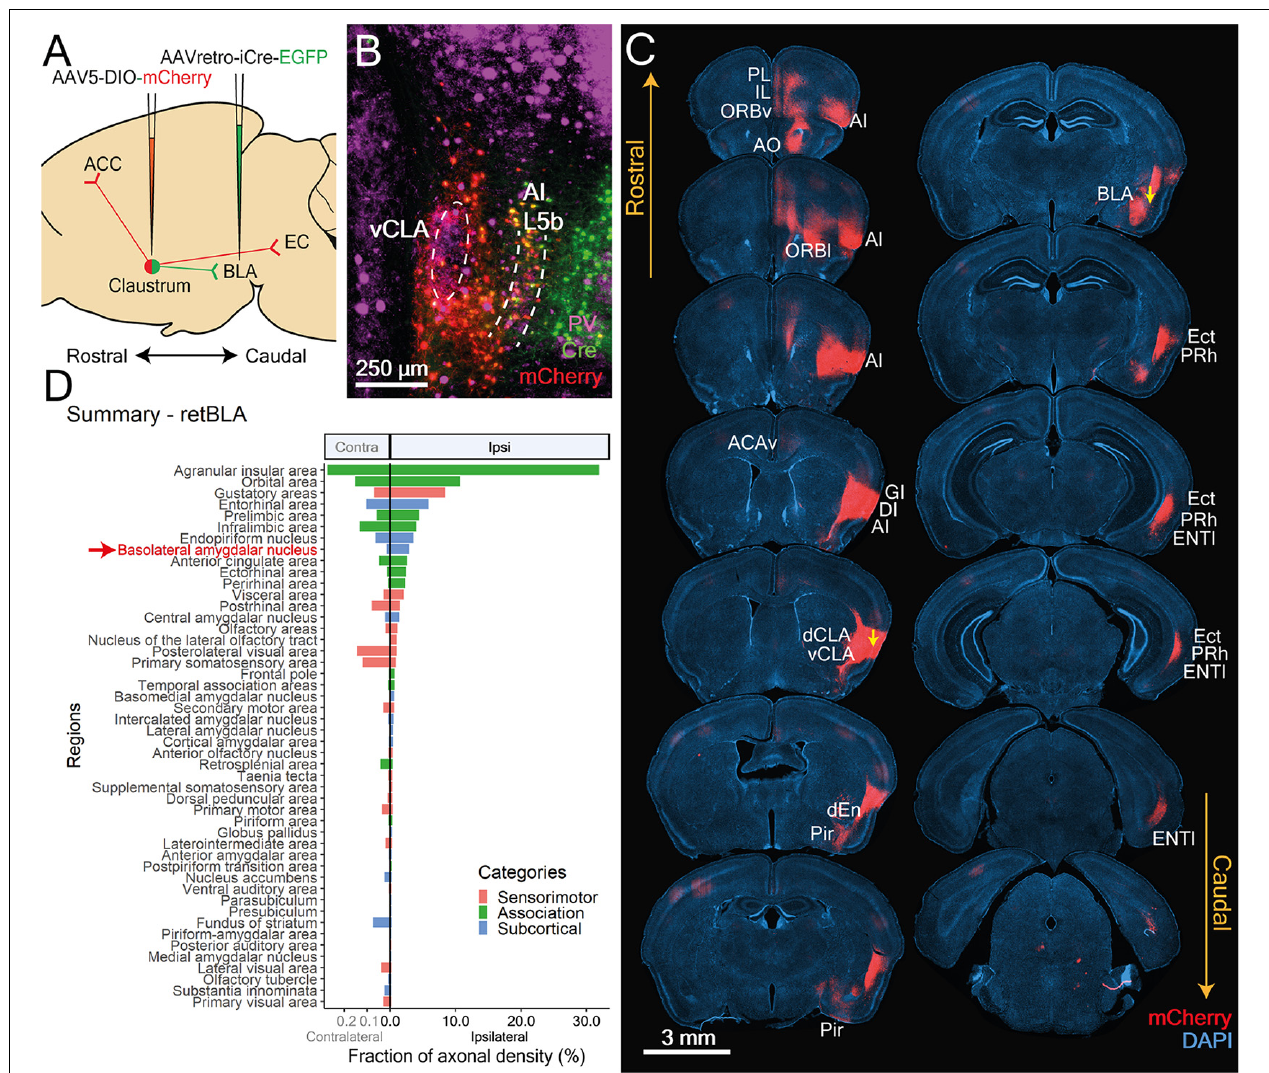
FIGURE 7 | CLA neurons projecting to the BLA reside in a shell-like region surrounding the vCLA core and co-project to limbic-related cortices. (A) Illustration of double virus injection strategy used to label CLA neurons projecting to the BLA and its axon arborizations. (B) CLA-specific expression of Cre and mCherry based on experiment shown in (A) . vCLA core boundaries (white dotted ellipse) and layer 5b of the anterior insula (white dotted lines) are demarcated based on parvalbumin (PV) antibody staining. (C) Mapping of axon collateral from BLA-projecting CLA neurons. Raw images of mCherry expression against DAPI stained coronal sections. Yellow arrows denote viral injection sites. CLA neurons projecting to BLA also project to several other limbic-related cortices. Regions receiving arborizations are labeled. PL, Prelimbic; IL, Infralimbic; AO, anterior olfactory nucleus; AI, Agranular insula; ORBv, ORBl, Orbital cortex ventral, lateral; ACCv, Anterior cingulate cortex ventral; GI, DI, Granular, Dysgranular Insula; dCLA, vCLA, dorsal, ventral claustrum; dEn, dorsal endopiriform nucleus; Pir, Piriform cortex; BLA, Basolateral amygdala; Ect, Ectorhinal cortex; Prh, Perirhinal cortex; LEC, Lateral entorhinal cortex; Sub, Subiculum. (D) Mean fraction of axonal density for all innervated regions sorted by strength. Red arrow and text identify retrograde Cre origin: BLA. Several regions had heavier innervation compared to the BLA. These include the agranular insula, orbital, gustatory, entorhinal, prelimbic, and infralimbic cortices as well as the endopiriform nucleus. Colors represent region categories: Association—green, Sensorimotor—pink, and Subcortical—Blue. Note different ranges for contralateral and ipsilateral